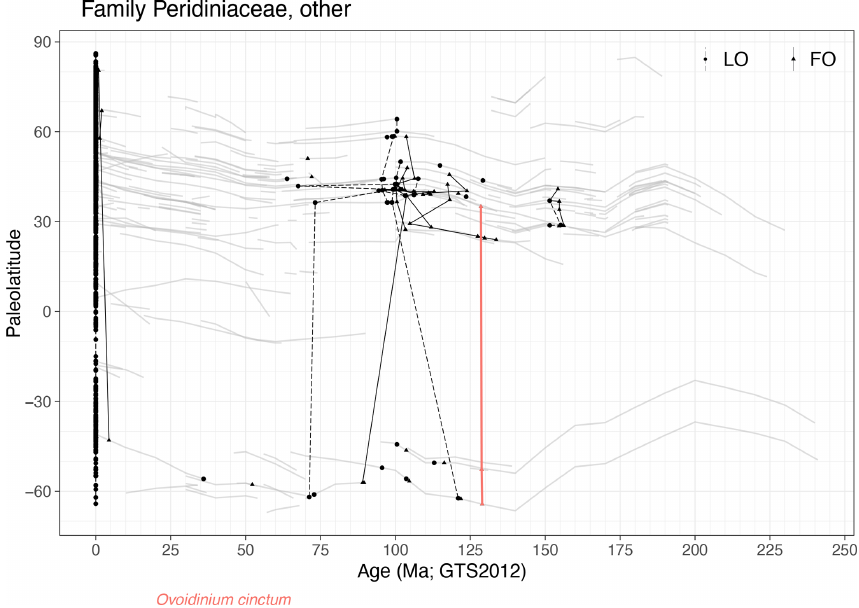
Figure 24. Same as Fig. 5 but for other subfamilies in the Family Peridiniaceae.